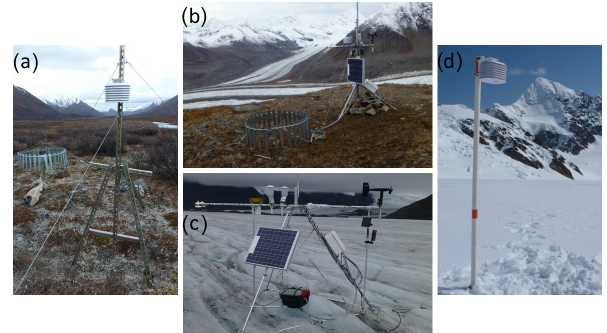
3 Climatological and meteorological data